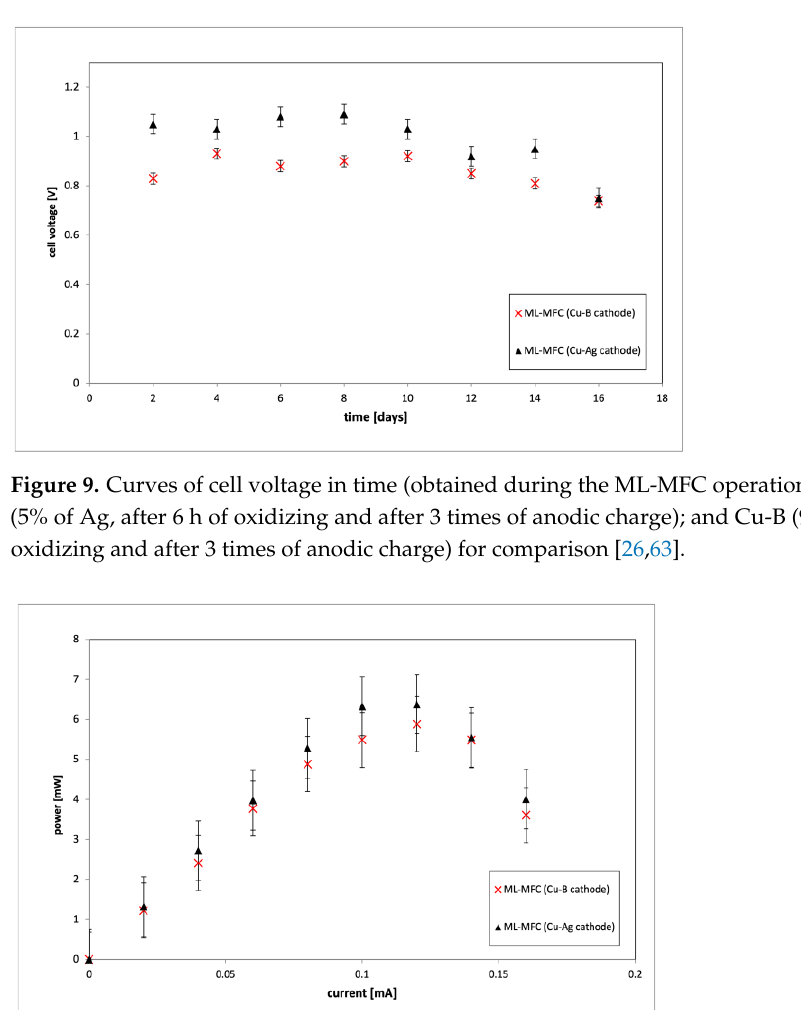
Table 3. Power and voltage (maximum value) obtained in ML-MFC (powered with PYWW). Cath- ode: Cu-Ag (foam form) oxidized for 6 h, and after an anodic charge (after 1, 2, 3, 4 times of charg- ing).